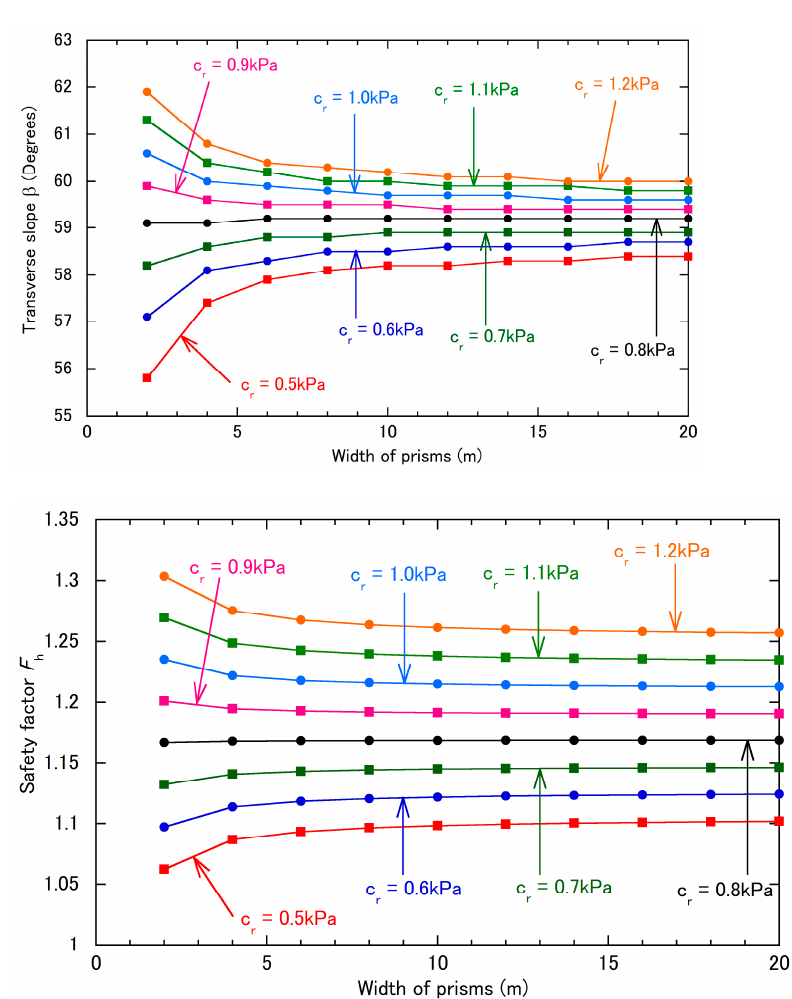
Figure 5. Results of slope-stability analysis obtained using Hovland’s method. Changes in ( a ) the transverse slope ( β ) and ( b ) safety factor, according to prism width.